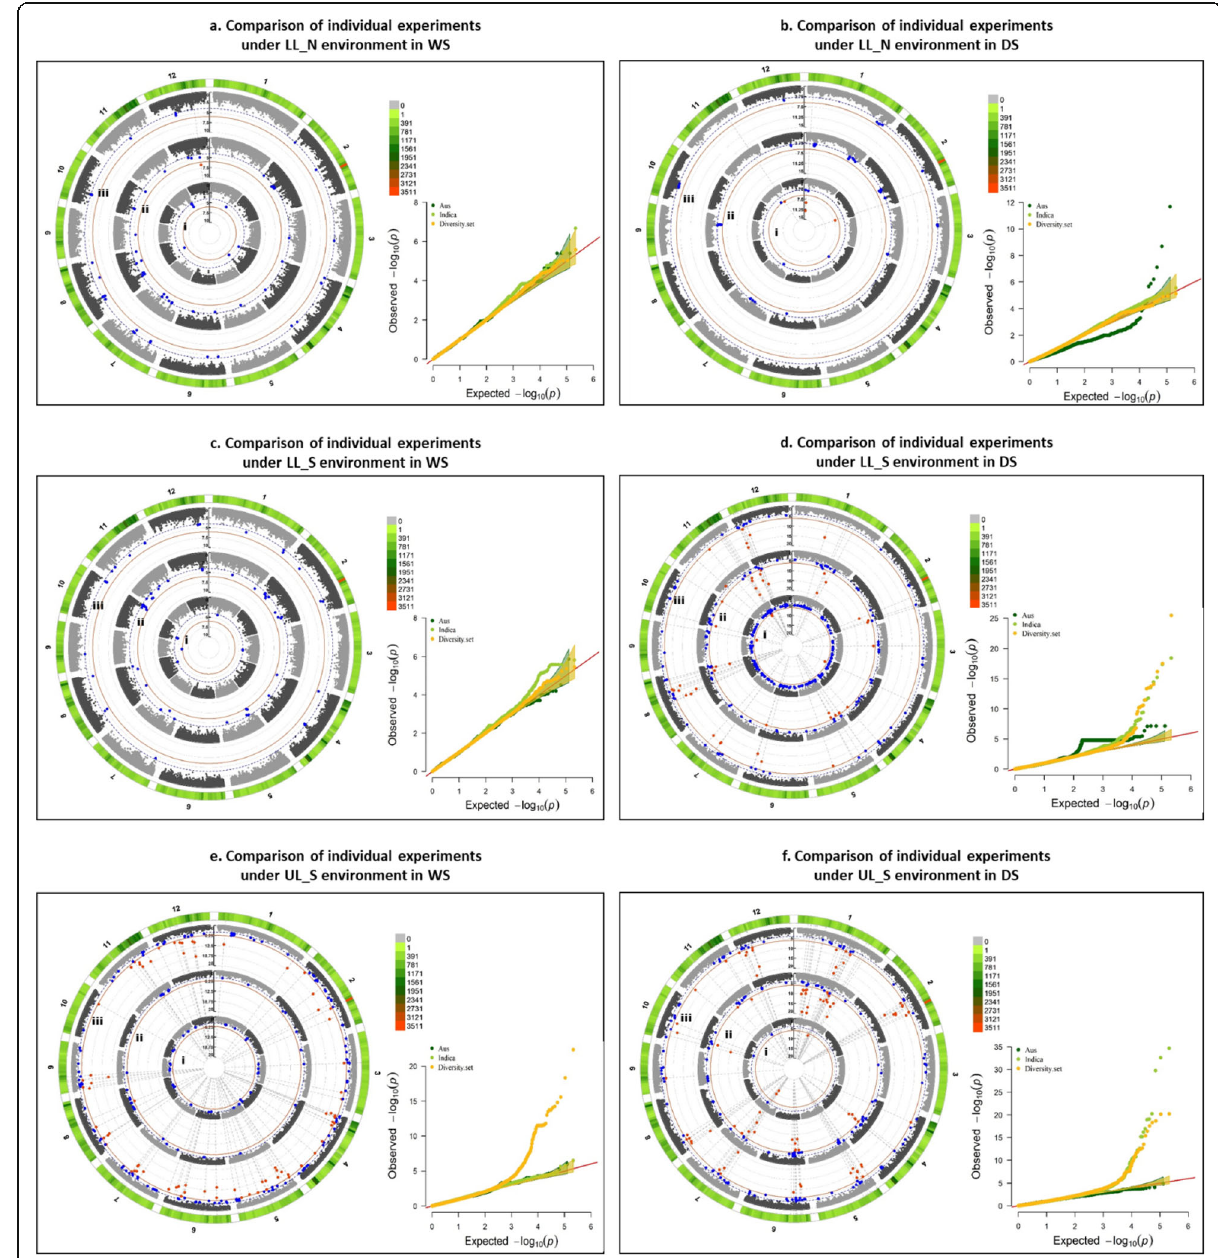
Fig. 7 Circular manhattan plot and qq plot for Grain yield (GY) for- a . lowland non-stress 2014WS (LL_N_WS); b . lowland non-stress 2015DS (LL_N_DS); c . lowland stress 2014WS (LL_S_WS); d . lowland stress 2015DS (LL_S_DS); e . upland stress 2014WS (UL_S_WS); f . upland stress 2015DS (UL_S_DS) divided into two levels- subgroup level with i . aus lines and ii . indica lines and iii. comlpete diversity set of 280 lines for p -values obtained using Farm-CPU menthod at two significance thresholds of 1e-4 (blue) and 1e-6 (red). The outermost ring depicts the SNP distribution in the 215,250 SNP working set; to explore the effect of population structure in detection of significant marker trait